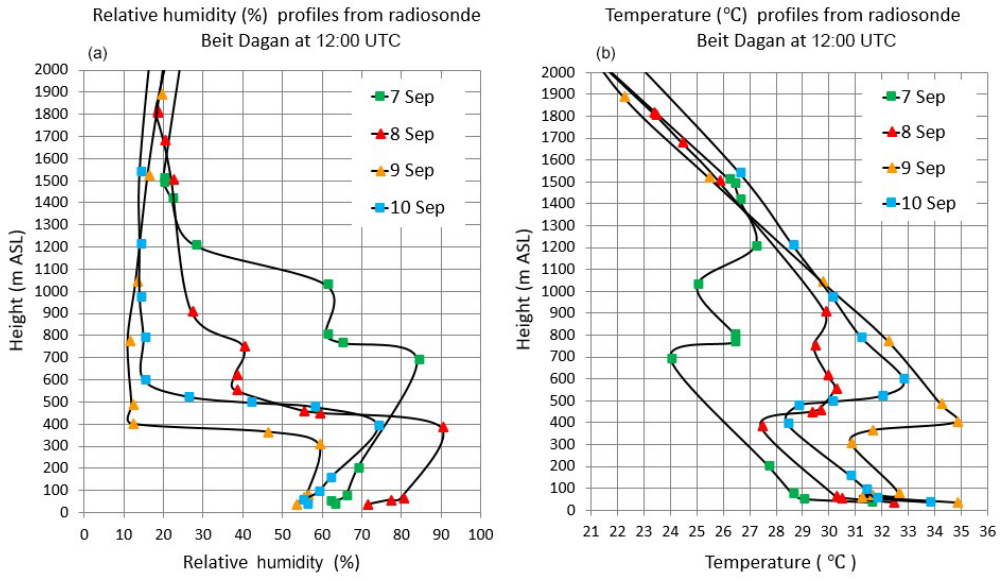
Figure 16. Radiosonde Beit Dagan profiles at 12:00UTC between 7 and 10 September 2015 of relative humidity (a) and temperature (b)